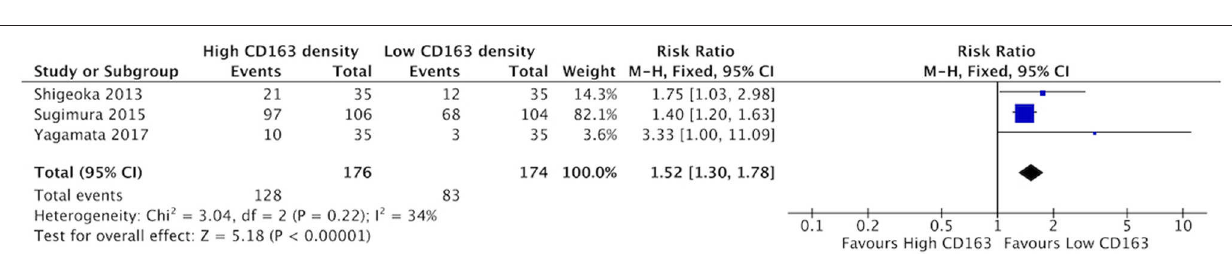
FIGURE 8 | High CD68 + TAM density is associated with higher rates of lymphatic invasion.